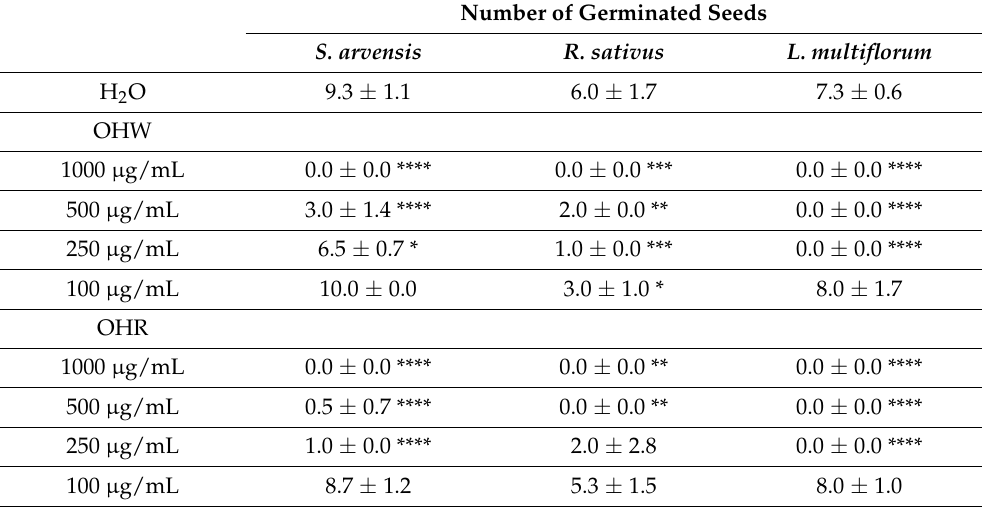
Table 2. Germination of R. sativus , S. arvensis and L. multiflorum seeds treated with different doses of EOs. The measurement was carried out 120 h after sowing. Results are expressed as the mean of three experiments ± SD.